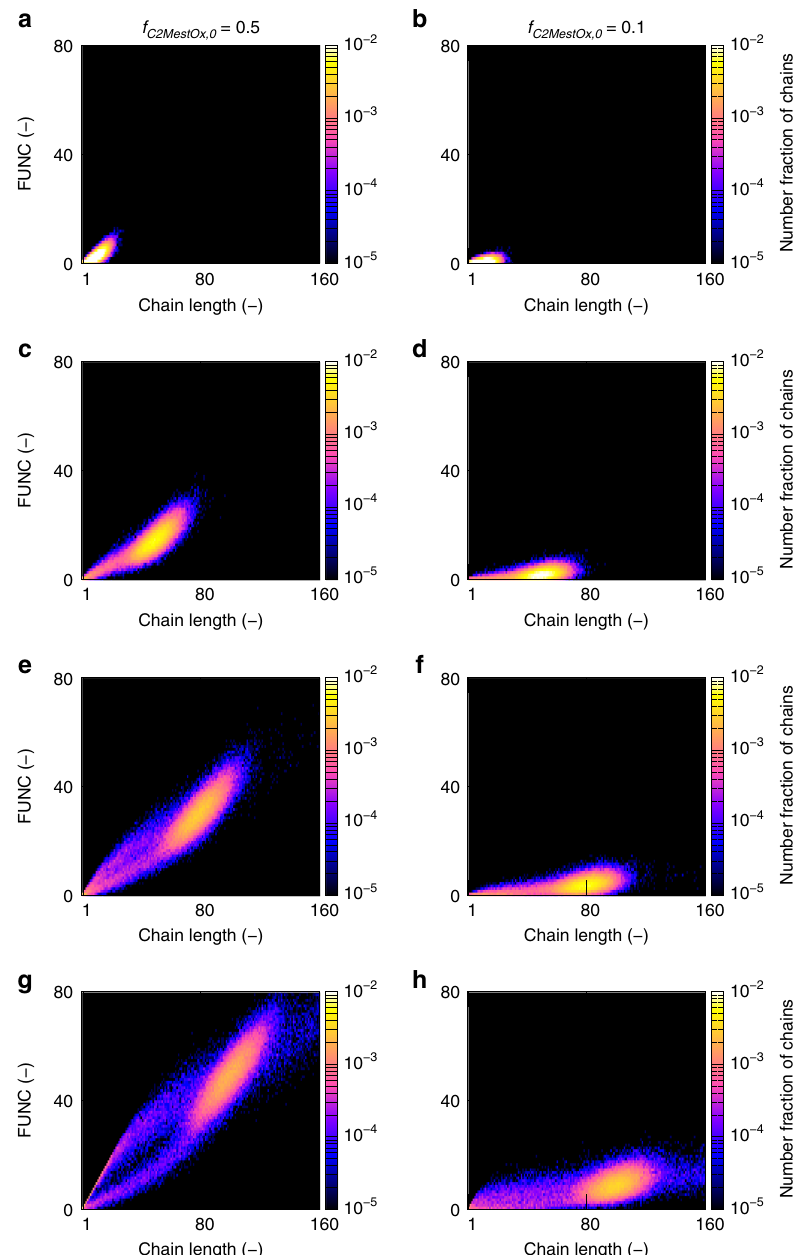
Fig. 5 Functionalization — chain length distribution (FUNC-CLD) or fi ngerprint for CROP of MeOx and C2MestOx. Variations are included for an initial amount of C2MestOx ( f C2MestOx,0 ) of 0.5 and 0.1 (total monomer concentration: 3 mol L − 1 ; solvent acetonitrile; target DP of 100; 140 °C) at (overall) monomer conversion of a , b 10%, c , d 50%, e , f 80%, and g , h 100%; at fi nal conversion a trimodal fi ngerprint